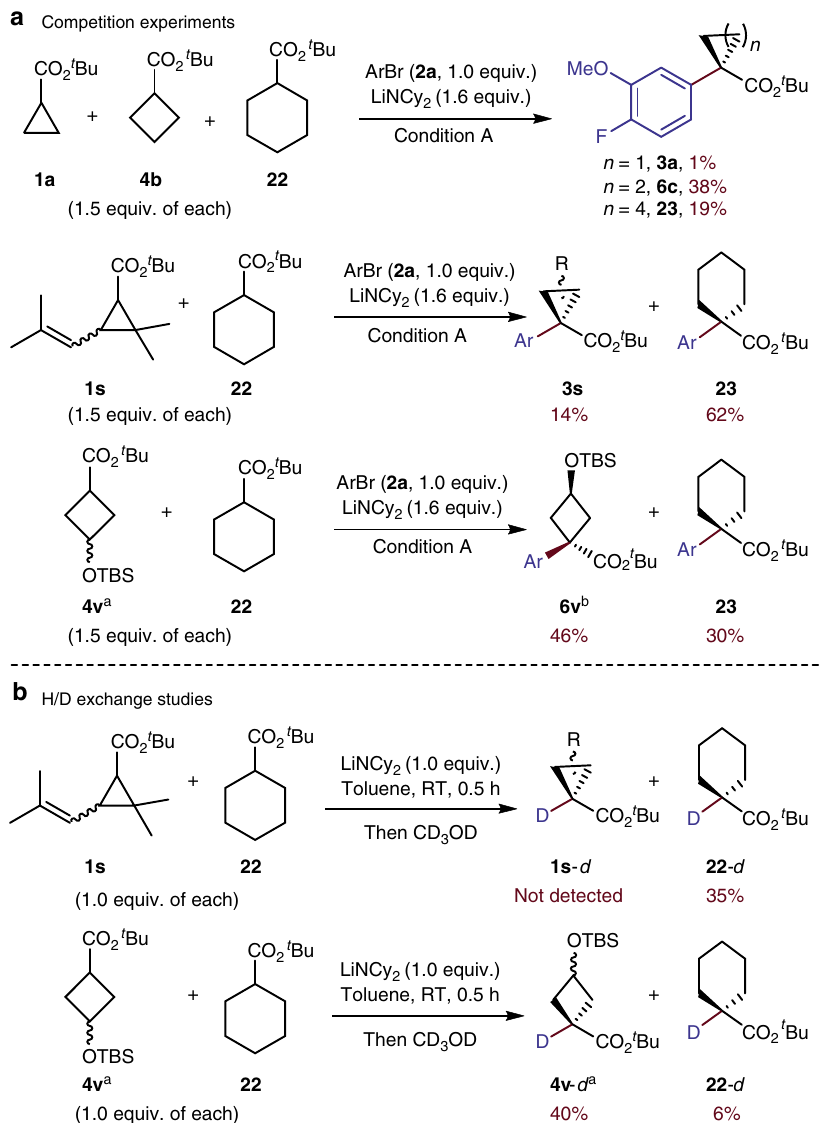
Fig. 7 Competition experiments and H/D exchange studies. a Competition experiments. b H/D exchange studies. Condition A: 4-bromo-1- fl uoro-2- methoxybenzene ( 2a , 1.0 equiv.), [Pd] − 5 (5 mol%), AgBF 4 (5 mol%), LiNCy 2 (1.6 equiv.), toluene, 50 ° C, 12 h. a Mixtures of two isomers, dr 9:1. b Major isomer is shown, dr